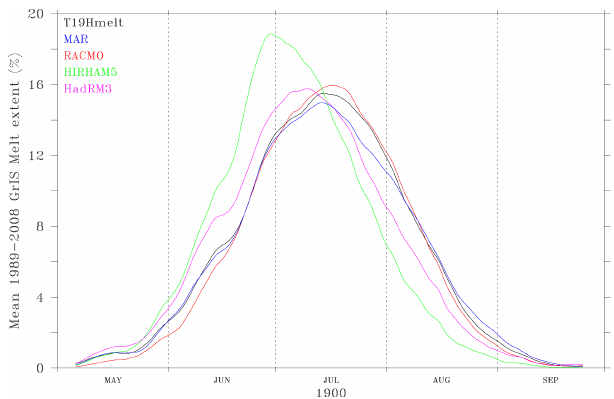
Fig. 5. 20-yr mean seasonal cycle (1989–2008) of melt area (in % of ice sheet area) from the four RCMs and from satellite microwave data via the T19Hmelt algorithm.